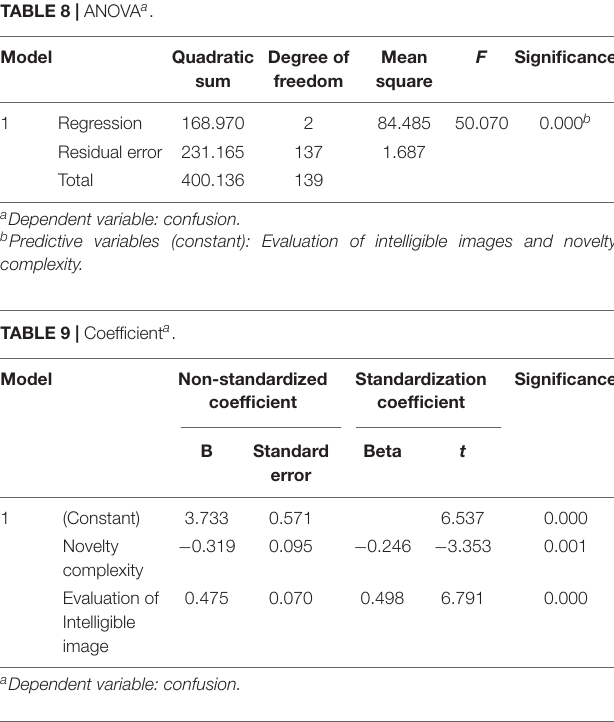
TABLE 8 | ANOVA a .